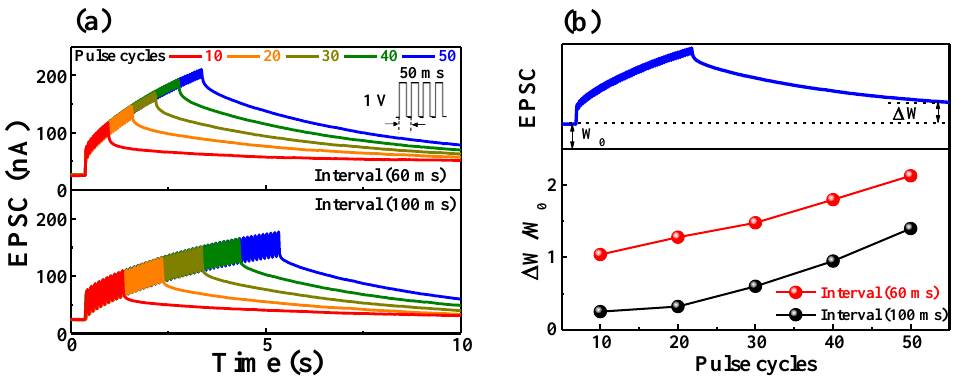
Figure 5. ( a ) EPSC recorded in response to presynaptic stimulation of multiple spikes (10–50 cycles); ( b ) change in synaptic weight according to the input pulse number. W0 is the initial EPSC before stimulation, and ∆W is the EPSC change after 10 s.